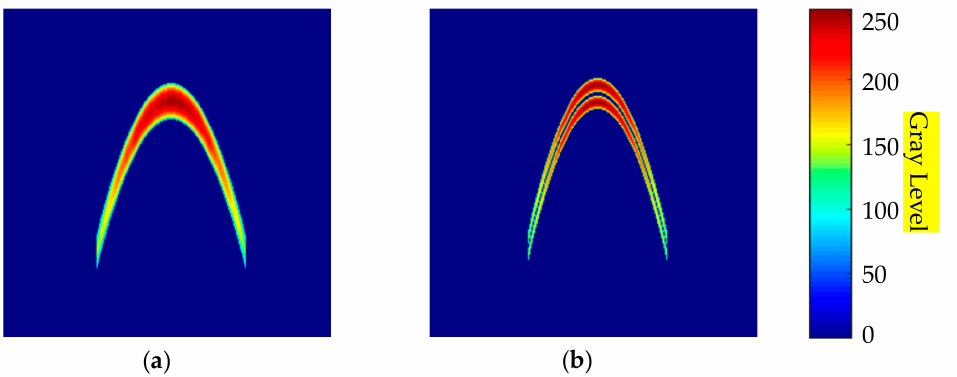
Figure 14. Pipeline image generated according to the theoretical formula. ( a ) Pipeline image with signal aliasing; ( b ) pipeline image without signal